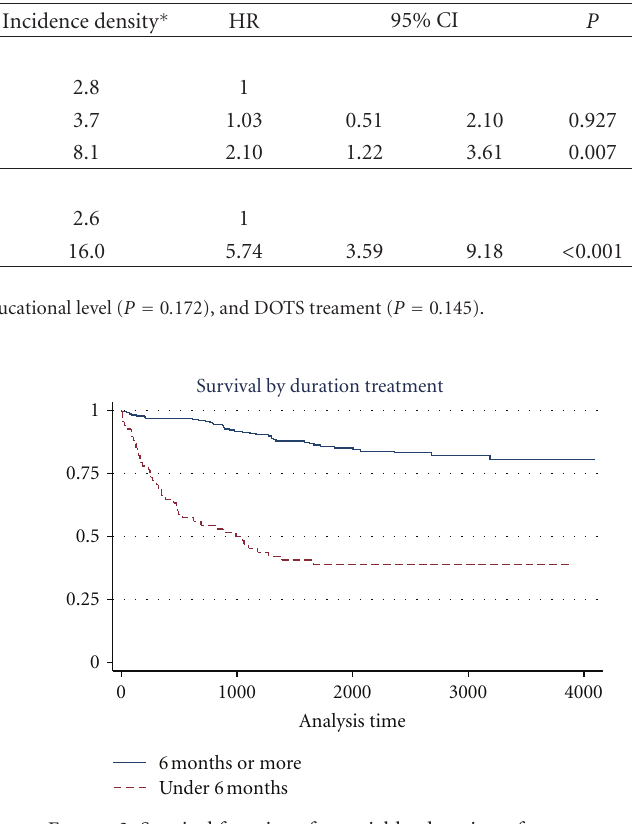
Figure 3: Survival functions for variable: duration of